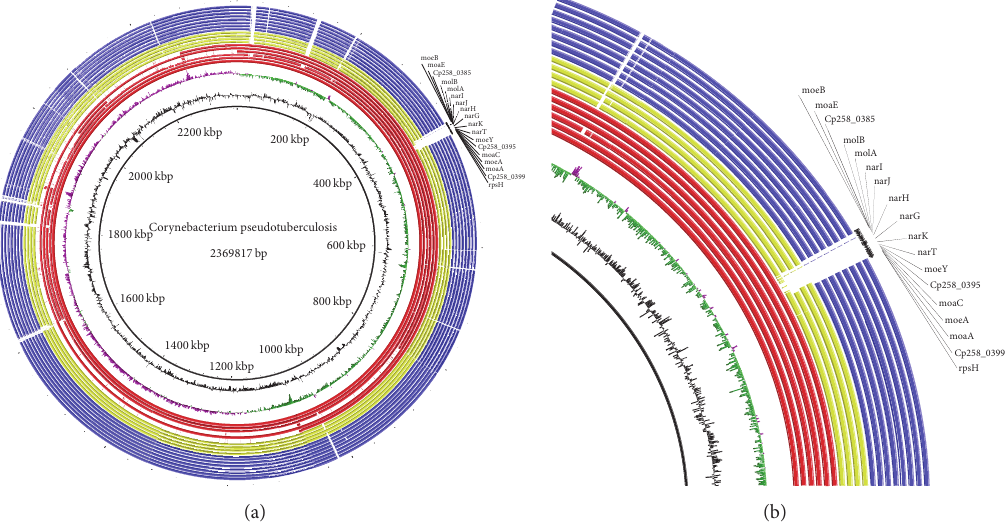
Figure 1: Graphical circular map showing BLAST between nineteen C. pseudotuberculosis strains. (a) From center to the outside: GC content in black and GC skew in pink and green; in red and yellow Equi strains and in blue Ovis strains. From the inner to outer circle on (a) and (b): the biovar Equi strains are the following: 258, 31, 262, MB20, E19, CCUG27541, CIP52.97, 1/06-A, 316, and 162, and the biovar Ovis strains are the following: 1002, C231, FRC41, I19, PAT10, 42/02-A, 3/99-5, 267, and P54B96. (b) Zoom to the nitrate locus , absent in the biovar Equi strains CIP52.97, 1/06 –A, 316, and 162 and all biovar Ovis strains.